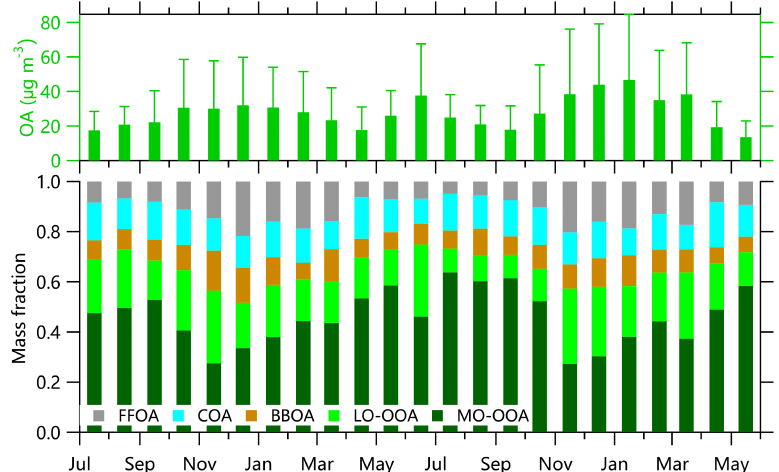
Figure 3. Monthly average OA mass concentrations and composition. The error bars represent 1 standard deviations of monthly averages.